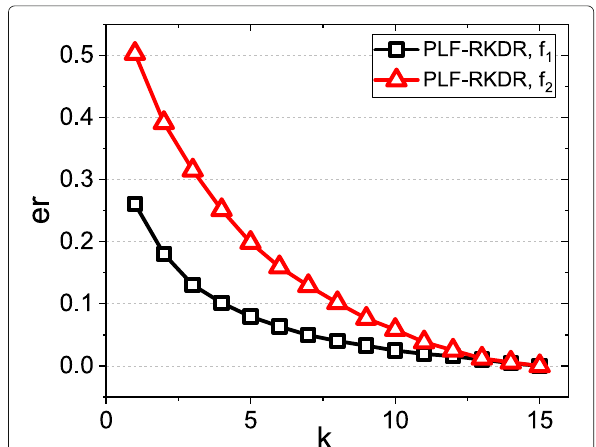
Fig. 4 The impact of k on the relative error of PLF-RKDR algorithm on the simulation dataset